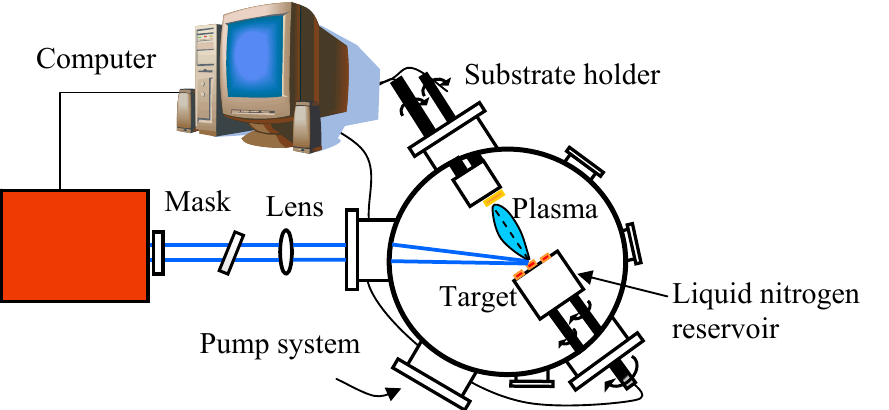
Figure 1 . Schematic diagram of a MAPLE deposition